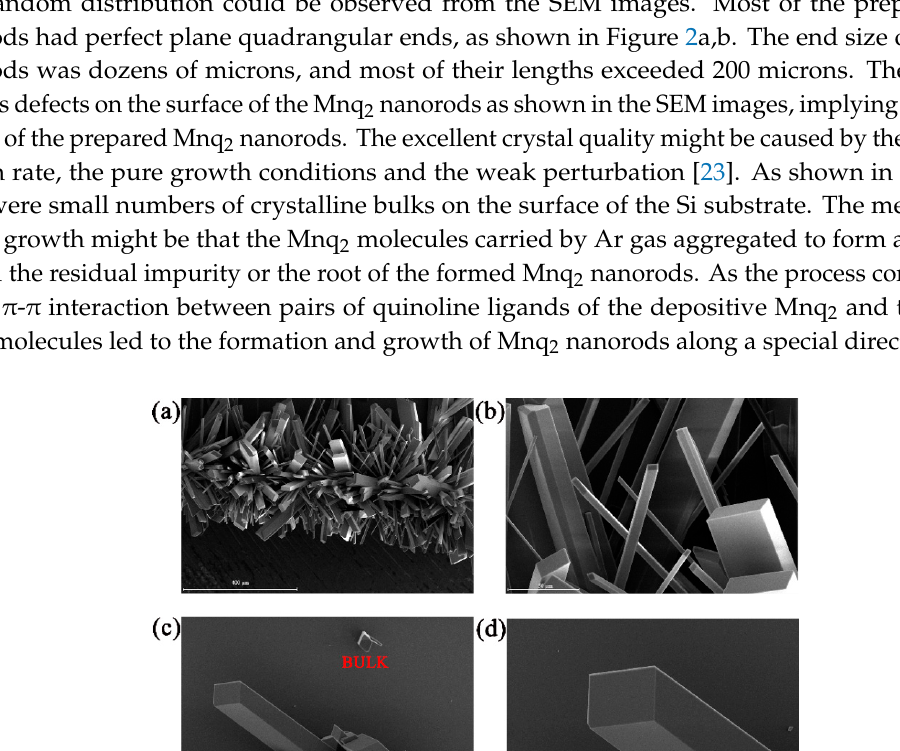
Figure 1. A diagrammatic sketch of the dual-zone tubular furnace.